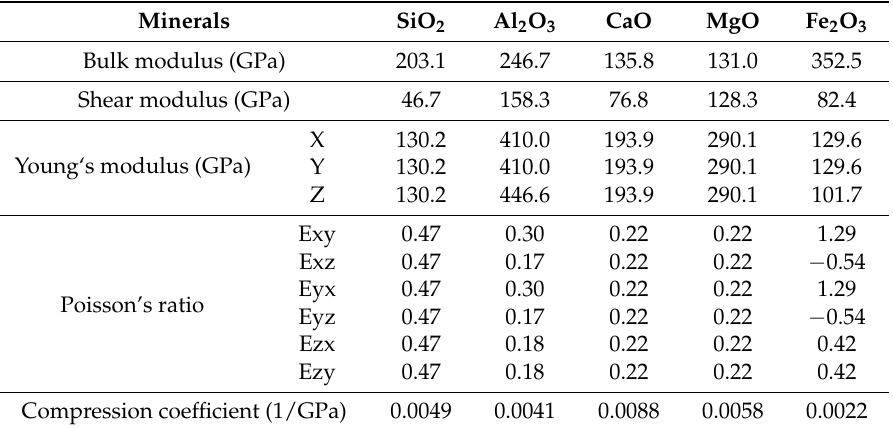
Table 1. The physical parameters of crystal structure model of different